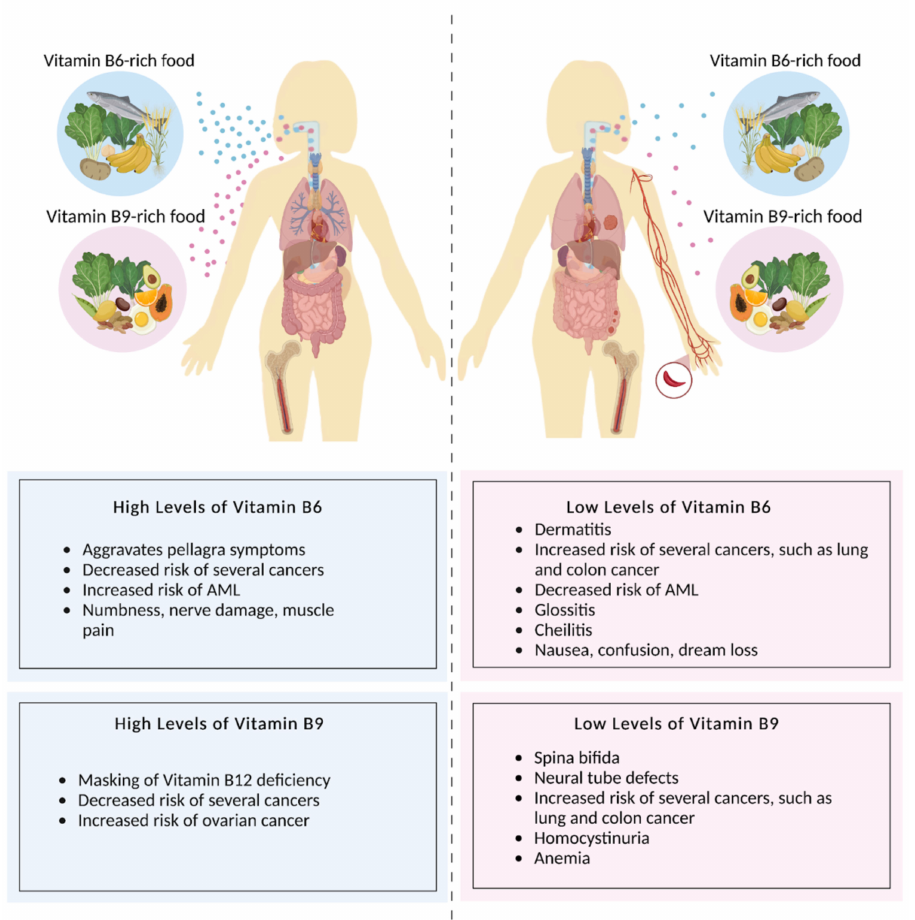
Figure 6. Dietary vitamin B6 and folate are essential for human health. Diets high in vitamin B6- and B9-rich foods (left) correlate with decreased risks of several cancers, but may mask the symptoms of a vitamin B12 deficiency, increase risk of ovarian and AML cancers, aggravate pellagra symptoms, and lead to numbness, nerve damage, and muscle pain. Diets low in vitamin B6- and B9-rich foods